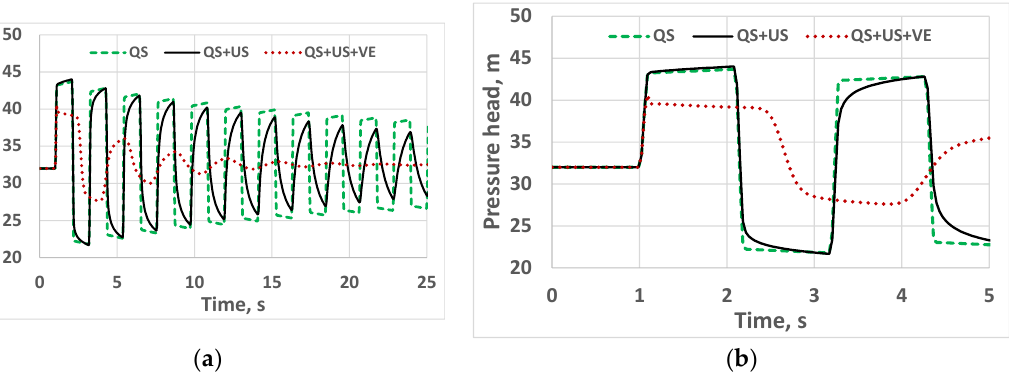
Figure 4. Influence of visco-elasticity on simulated pressures in an unsteady, turbulent, pipe flow induced by rapid valve closure. ( a ) Progressive decay. ( b ) Detailed form.